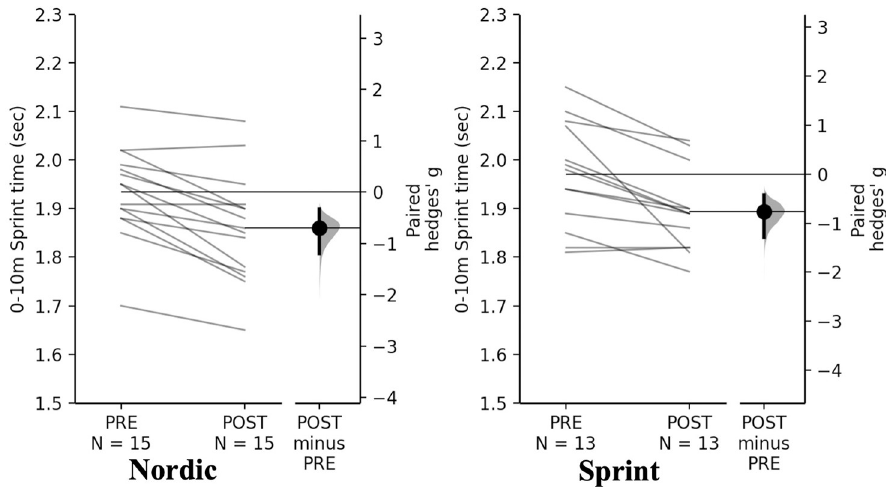
Fig 10. Gardner-Altman estimation plots identifying Pre- and Post-intervention individual changes for 0-10m sprint time and Hedge’s g effect size with the 95% CI indicated by the ends of the vertical error bar.